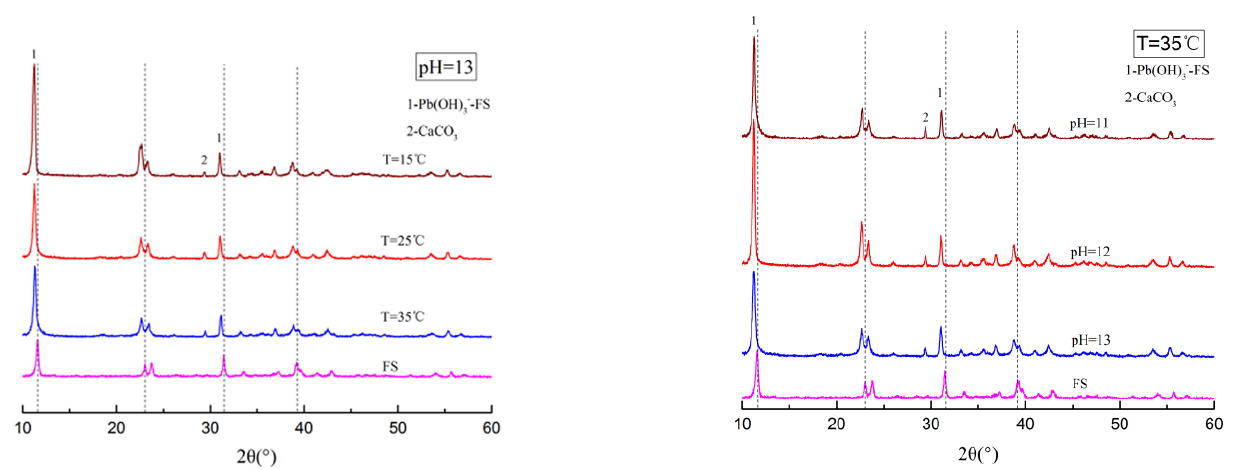
Figure 7. XRD patterns of solidification products at different temperatures and pH.